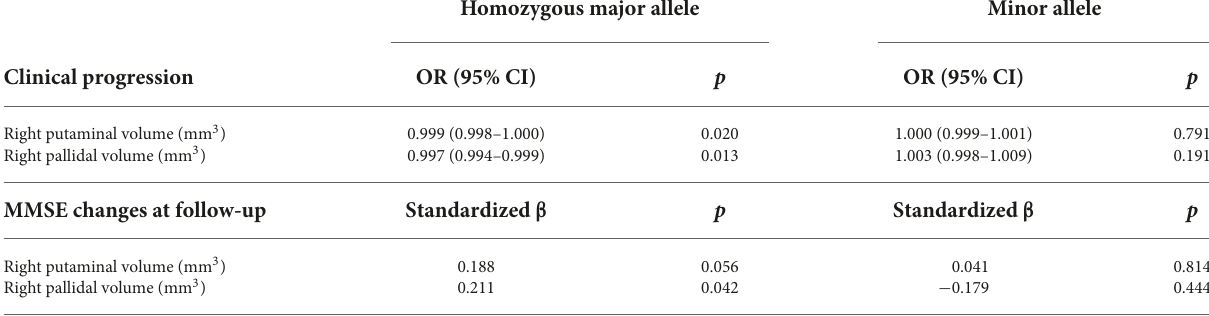
TABLE 5 Associations of the volumes of th right lentiform nucleus at baseline with clinical progression and MMSE changes at follow-up in homozygous major allele carriers ( n = 118) and minor allele carriers ( n = 38) of